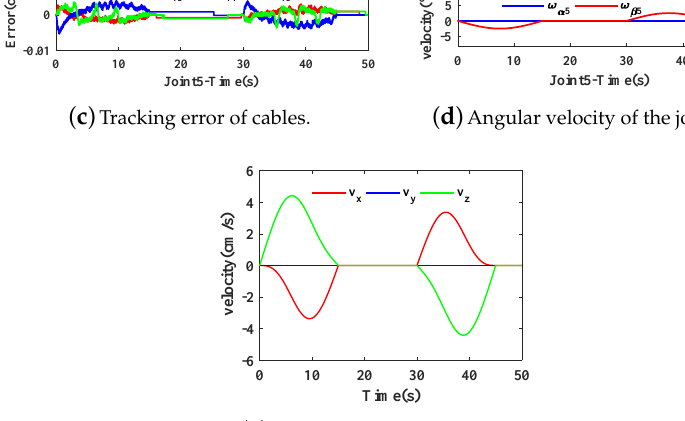
Figure 16. Experiment result of SET3 in the underwater